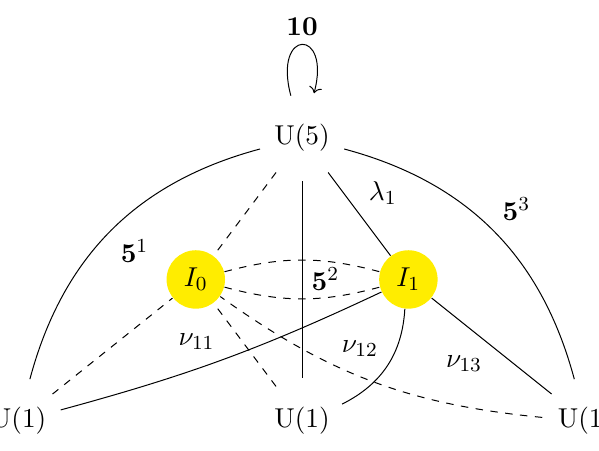
Figure 4 . Relevant zero modes for one D1 brane wrapping I 1 after orientifolding. Dashed lines indicate possible string states, but since I 0 is not occupied the play no relevance here. Labels such as (cid:23) 12 refer only to bold lines. Note that we have orientifolded the quiver shown